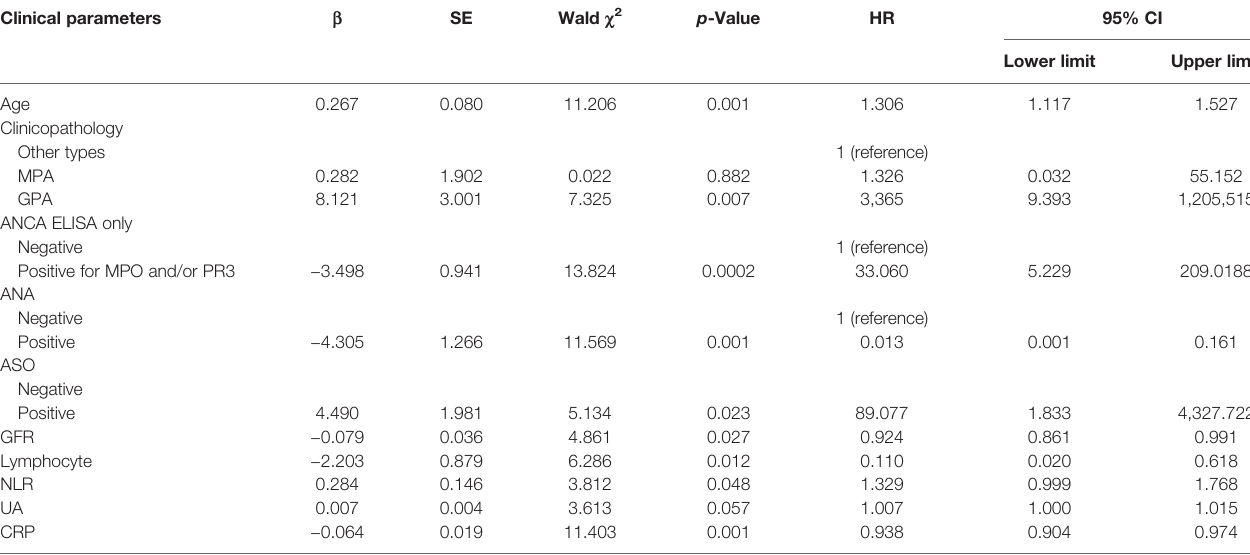
TABLE 2 | Multivariate Cox regression analysis for the association of clinical parameters with overall survival in AAV patients. Clinical